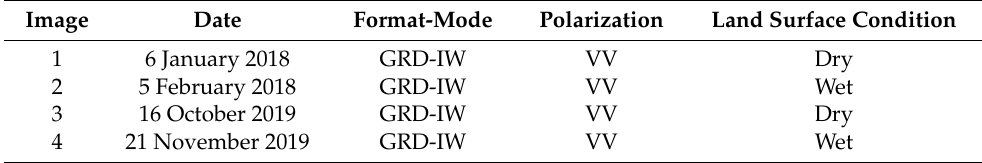
Table 2. Characteristics of the Sentinel-1 GRD data used to identify flooded areas.